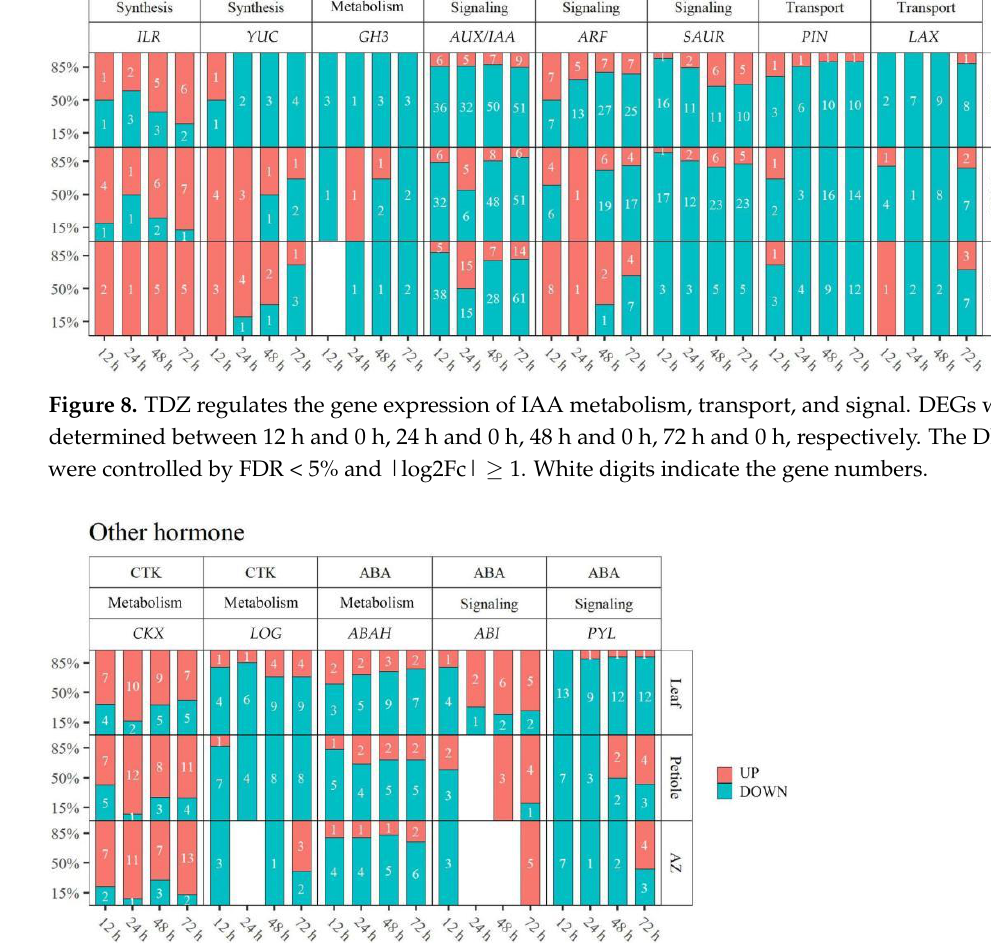
Figure 9. TDZ regulates the gene expression of metabolism and signal related to CTK and ABA. DEGs were determined between 12 h and 0 h, 24 h and 0 h, 48 h and 0 h, 72 h and 0 h, respectively. The DEGs were controlled by FDR<5% and |log2Fc|≥1. White digits indicate the gene numbers.